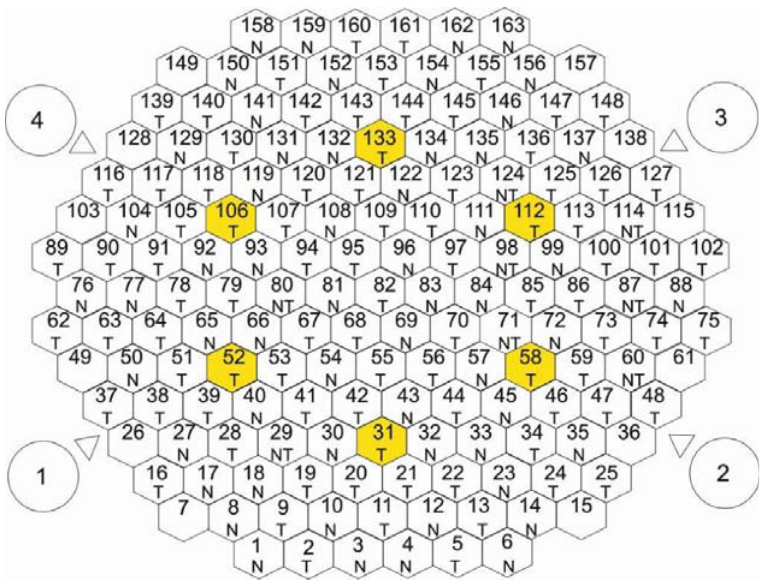
Figure 1: Core layout and position of the control rod cluster 10